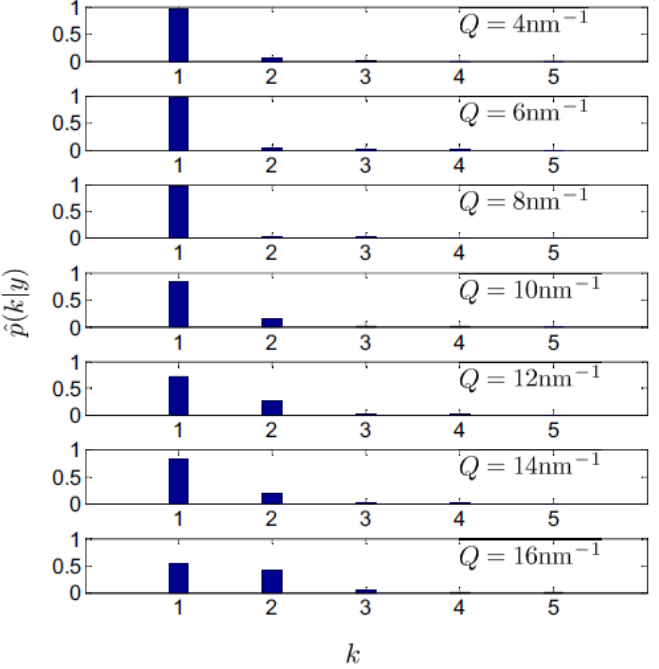
Figure 3. Posterior probability for the number of modes k for the various Q values probed in the INS measurement on liquid gold. Ref. [12]. Copyright (2016) of American Physical